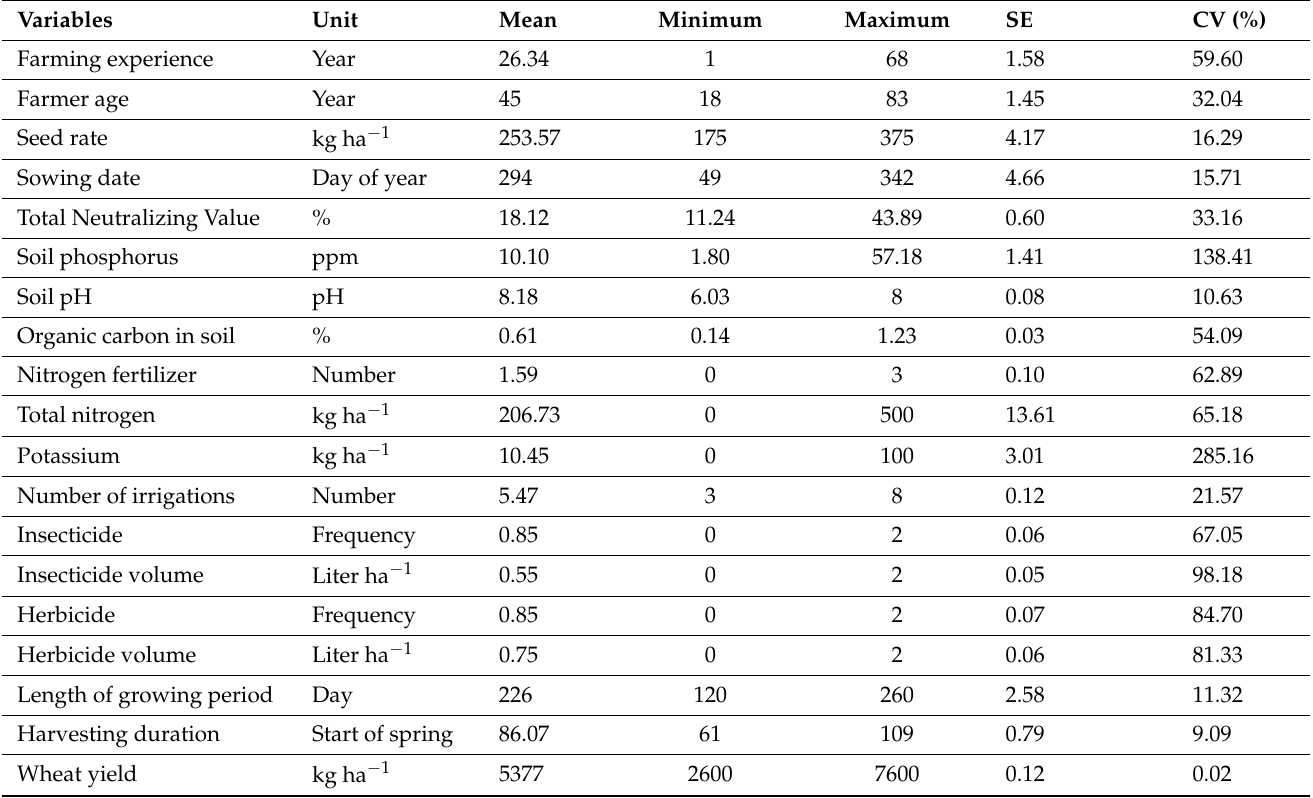
Table 1. Descriptive statistics of the studied variables in 104 wheat fields.